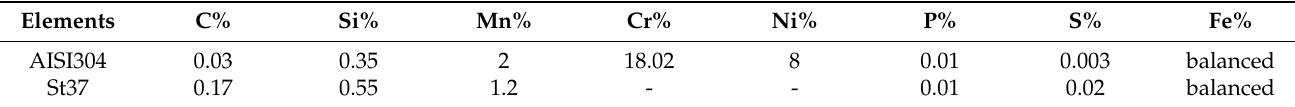
Table 1. Chemical composition of AISI304 and St37 steel.